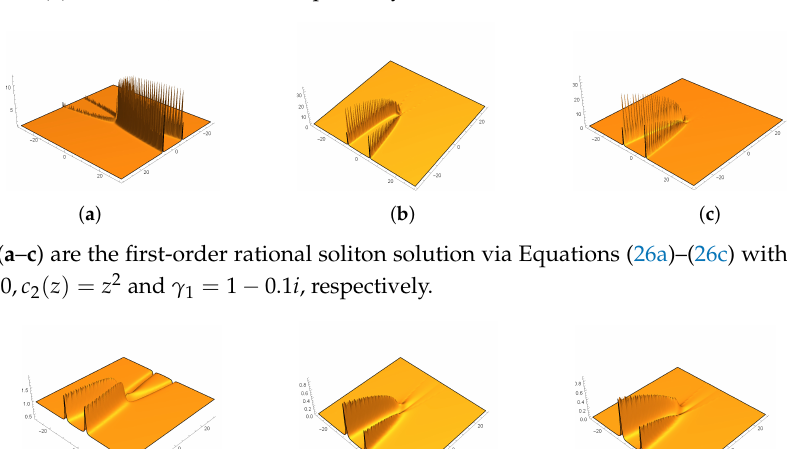
Figure 8. ( a – c ) are the first-order rational soliton solution via Equations (26a)–(26c) with ρ = 1, φ = 0, c 1 ( z ) = 0, c 2 ( z ) = z and γ 1 = 1 + 3 i , respectively.